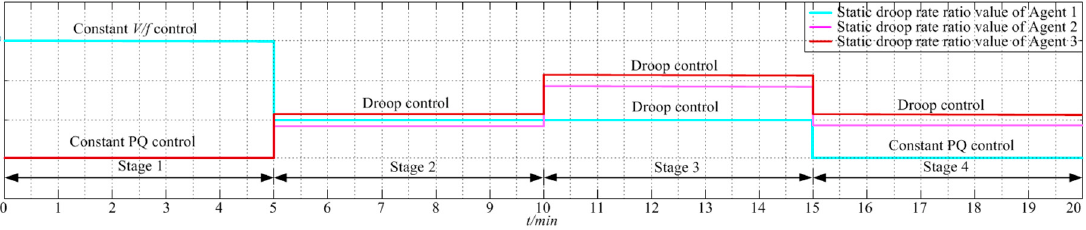
Figure 6. Active power outputs of DGs applying the SOC based strategy.